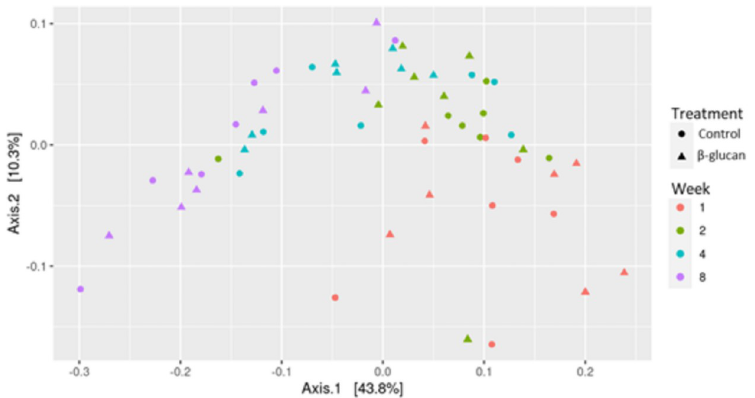
Fig 2. β -diversity of bacterial community in dairy calves’ feces fed milk replacer supplemented or not with β - glucans. Multidimensional scaling (MDS) showing the weighted UniFrac distance metric.